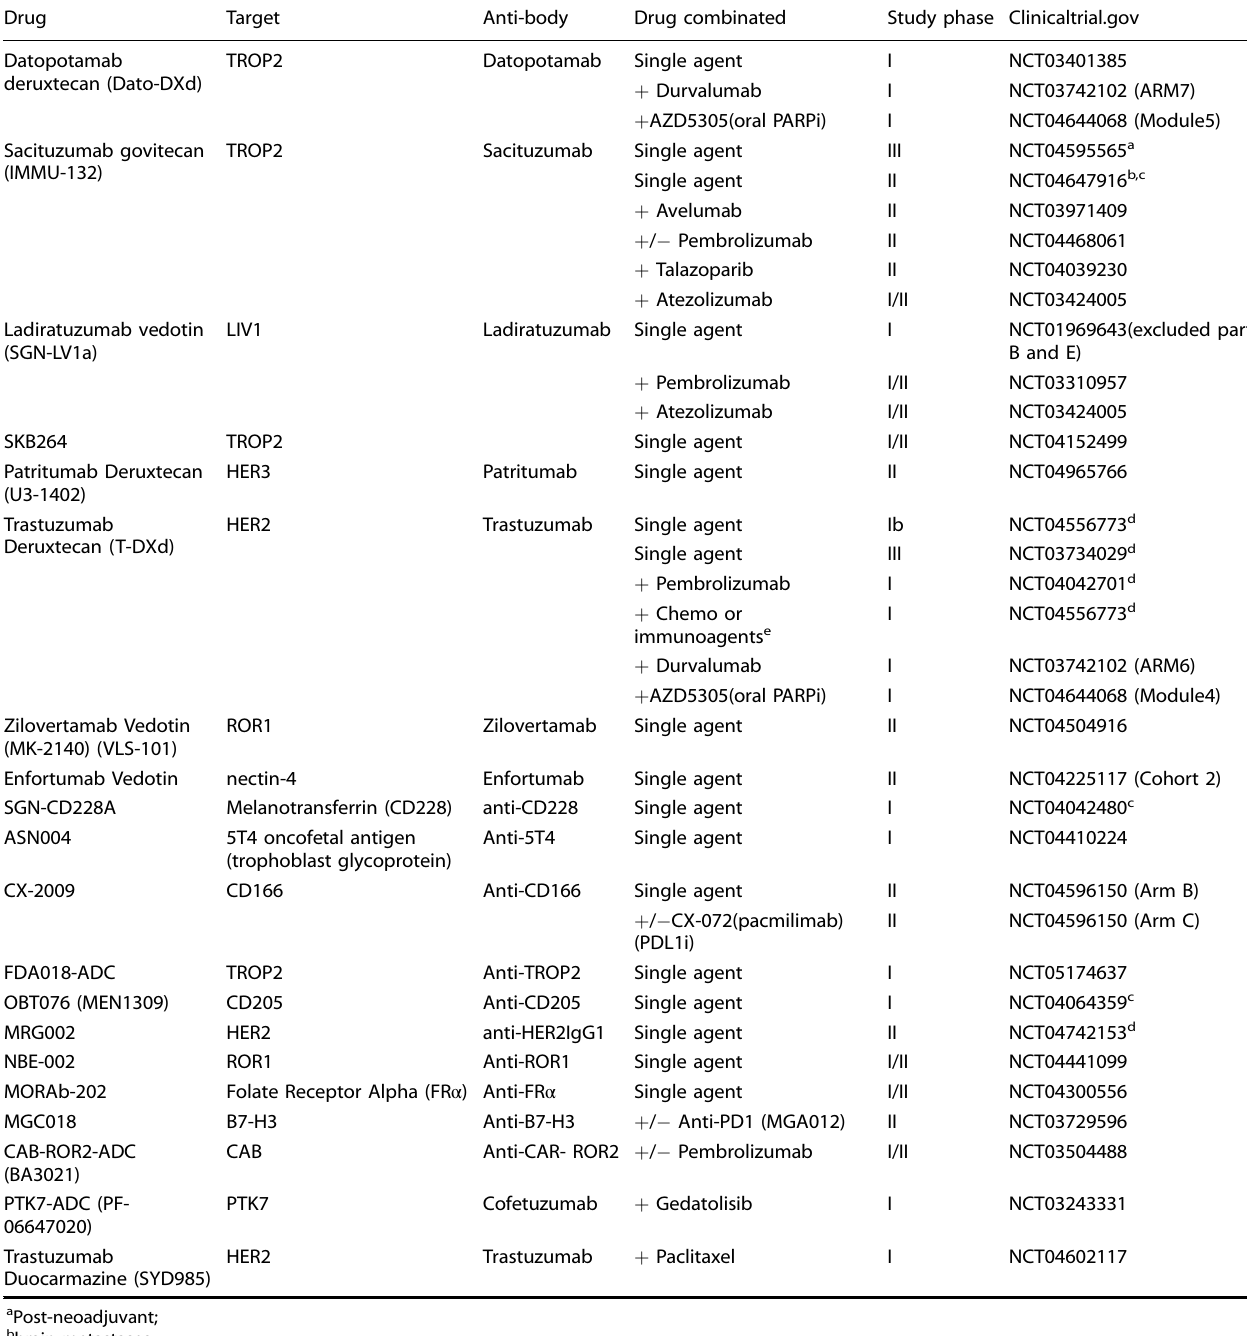
Table 1. Ongoing trials of antibody drug conjugates in TNBC. Drug Target Anti-body Drug